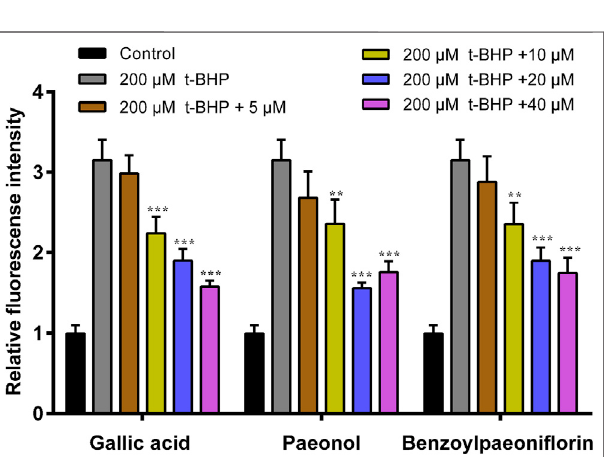
FIGURE 7 | Modulation of excess ROS by gallic acid, paeonol and benzoylpaeoni fl orin. Intracellular ROS was detected in t-BHP - induced RAW264.7 cells treated with indicated concentrations of gallic acid, paeonol and benzoylpaeoni fl orin and quanti fi ed by DCFH2-DA fl uorescence intensity assay. Compared with t-BHP treatment cell group, *** p < 0.001; ** p < 0.01; * p < 0.05.